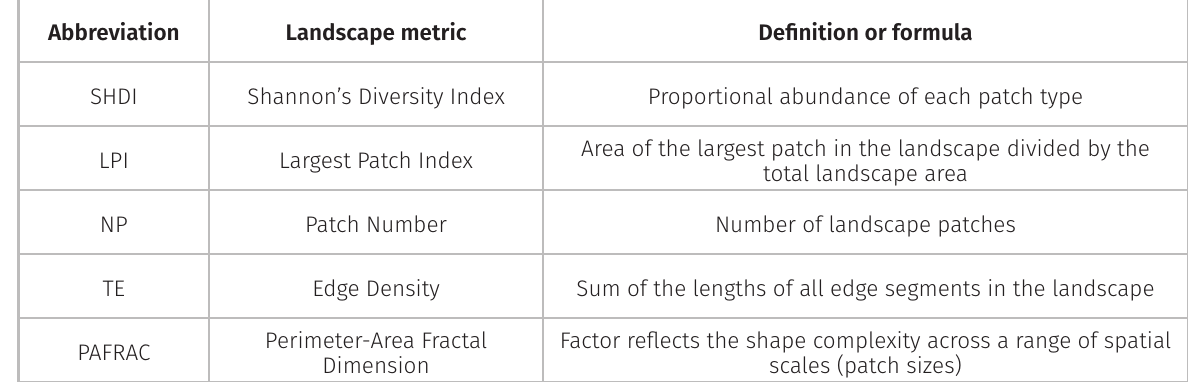
Table I. Five landscape